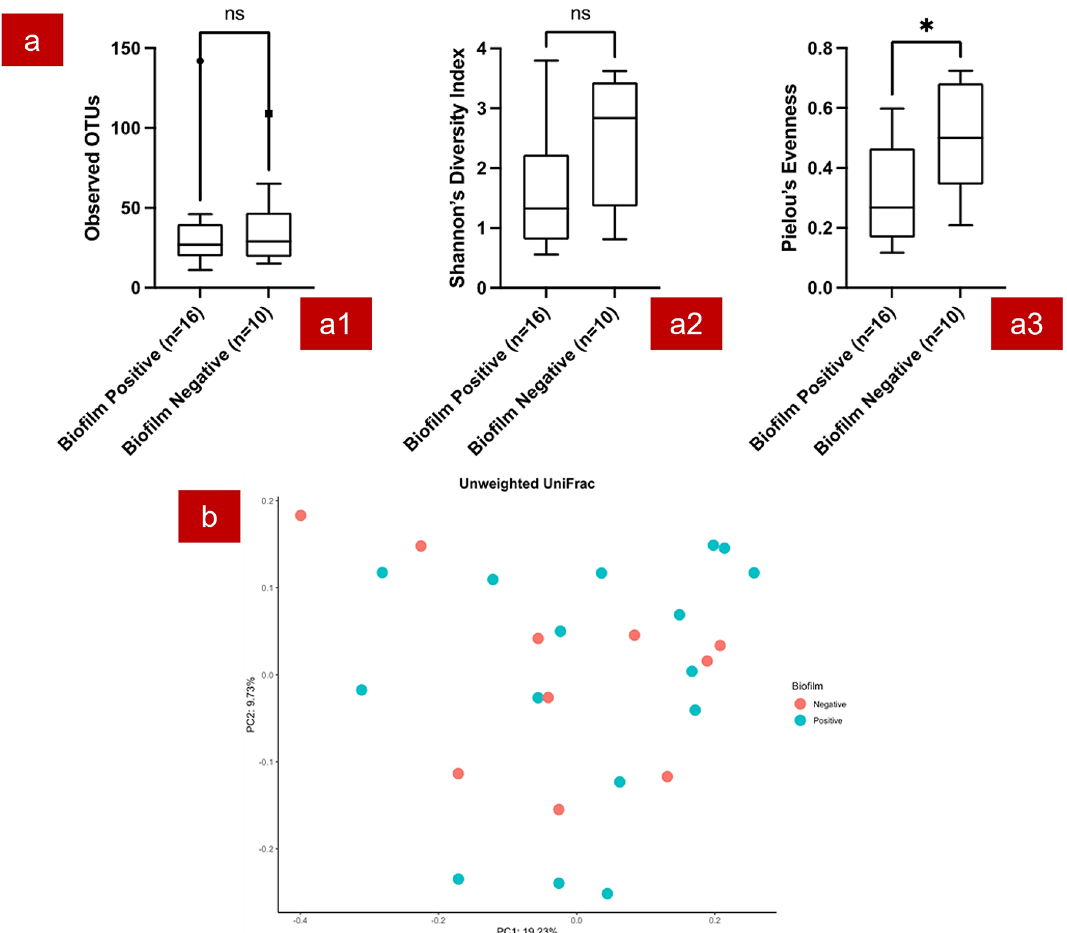
Figure 4. Diversity analysis results of the biofilm positive and negative wound biopsies. ( a ) Bacterial diversity based on biofilm positivity in wound biopsies. Observed OTUs (a1); Shannon–Wiener diversity index (a2); Pielou’s index (a3); ( b ) Unweighted Unifraction distance matrix based on biofilm positivity of the wound biopsies. *: statistically significant difference p ≤ 0.05; ns: no statistically significant difference p >